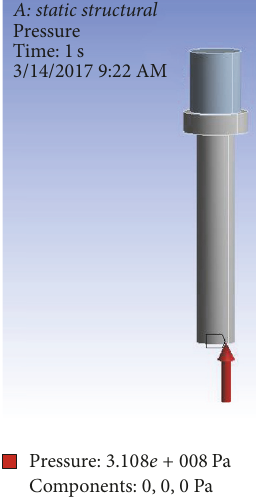
Figure 21: Applied pressure on